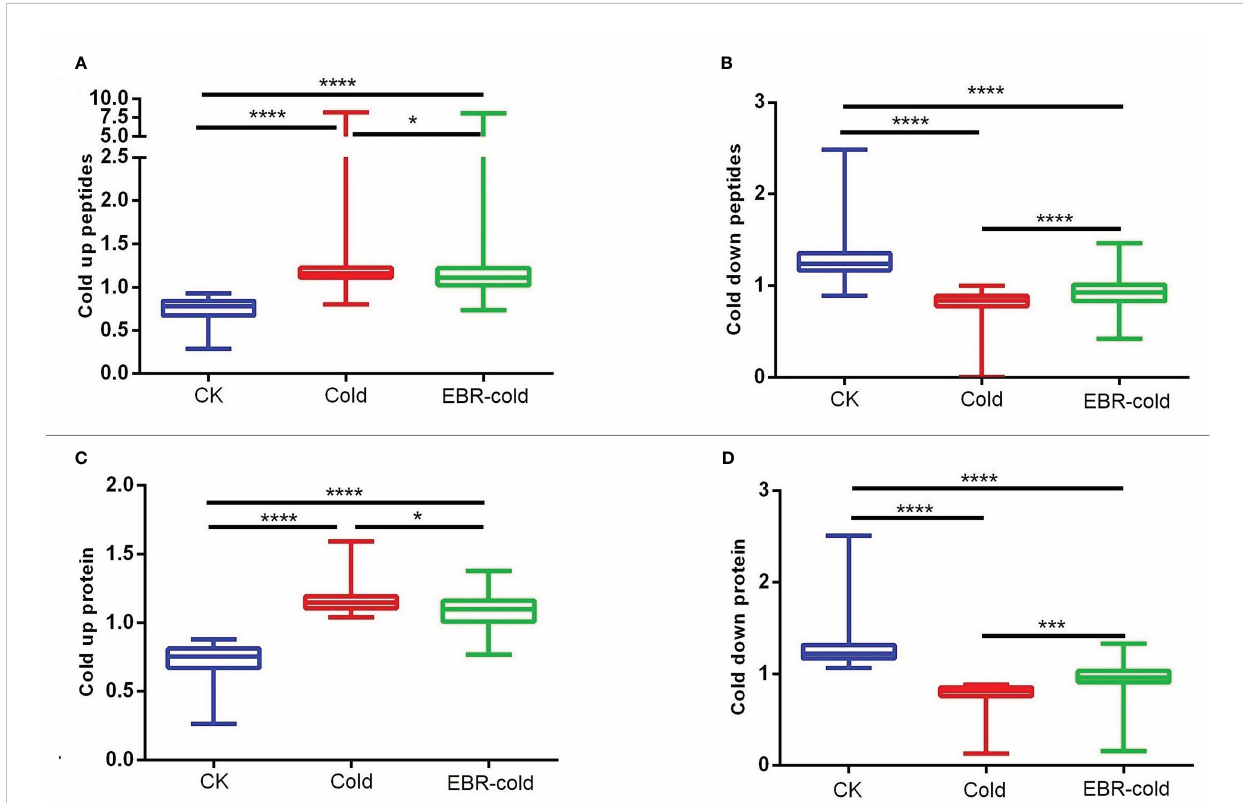
FIGURE 2 The regulation of EBR in cold-responsive phosphopeptides and cold-responsive proteins. (A, B) Cold-responsive phosphopeptides; (C, D) cold- responsive proteins. The "*" indicates signi fi cantly different (p < 0.05 by Tukey ’ s test), the "***" indicates signi fi cantly different (p < 0.001 by Tukey ’ s test), and "****" indicates signi fi cantly different (p < 0.0001 by Tukey ’ s